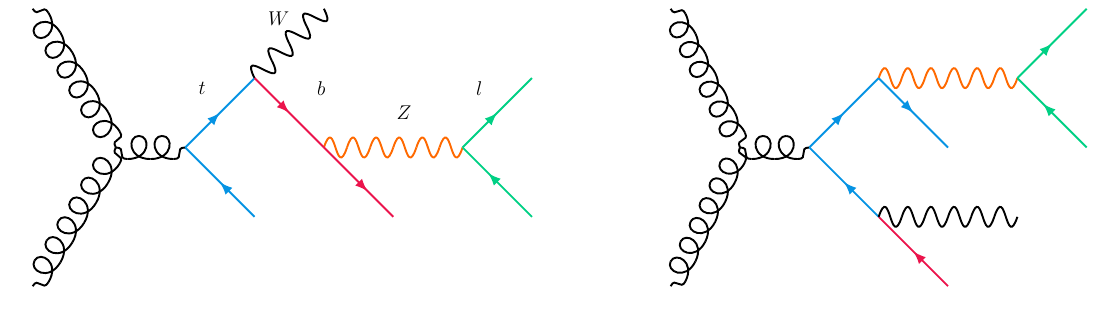
Figure 2 . Representative diagrams of the gg -initiated production of t ¯ t ( left ) and t ¯ tZ ( right ) processes with a potentially resonant (anti-)top quark leading to the t ¯ ‘‘Wb final